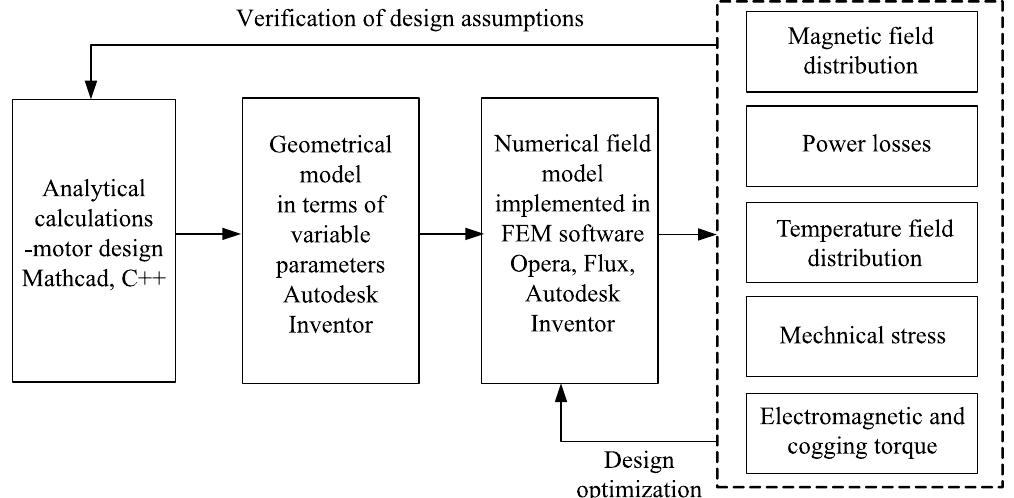
Figure 3. Design process and analysis of the electrical machine—analytical calculation, numerical field model implemented in FEM